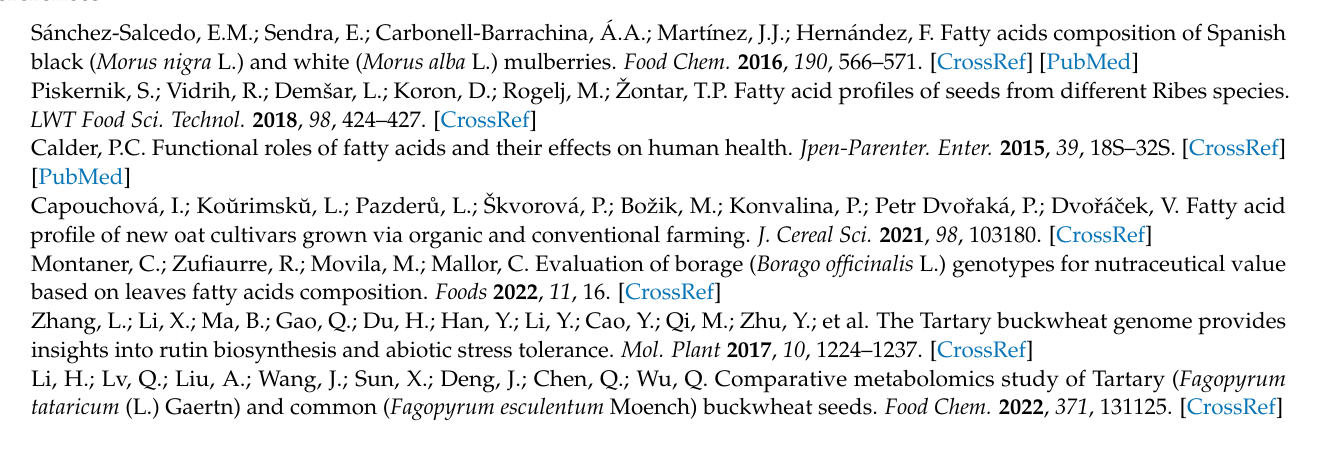
Table S3: The correlation between the expression of fatty acid biosynthesis genes and related fatty acids in the developing seed of Tartary